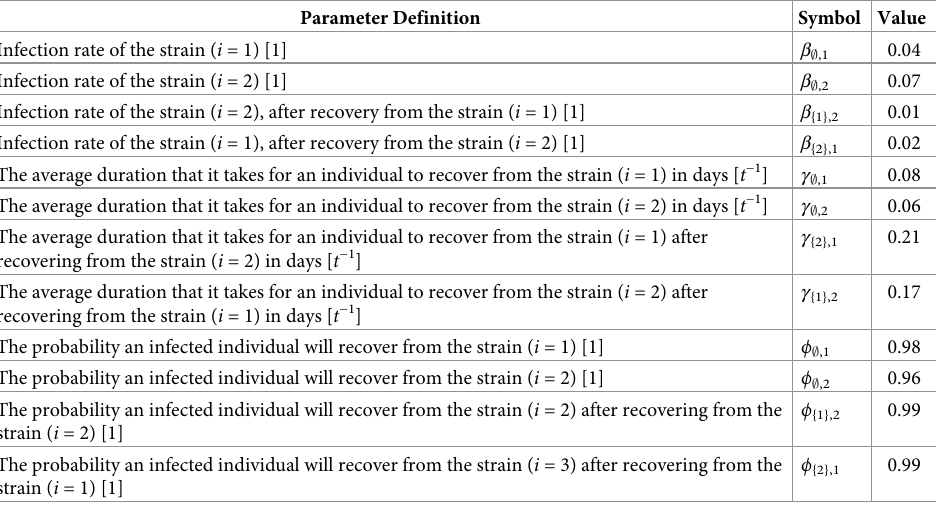
Table 1. A summary of the model parameters and values for the case of | M | = 2, obtained from the fitting process to the historical WHO COVID-19 data from April 1 (2020) to December 1